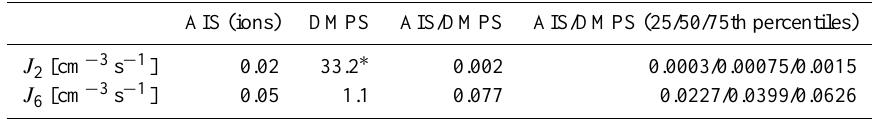
Table 6. Ion and total nucleation rates at different diameters, mean